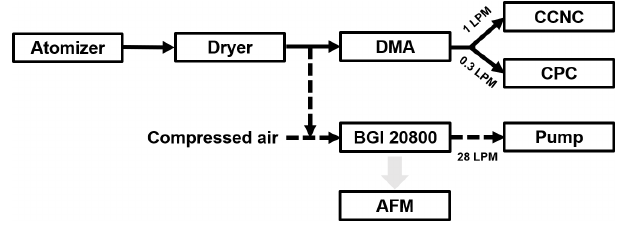
Figure 1. Schematic illustration of the instrumental setup. The ar- row indicates the flow direction. LPM stands for liters per